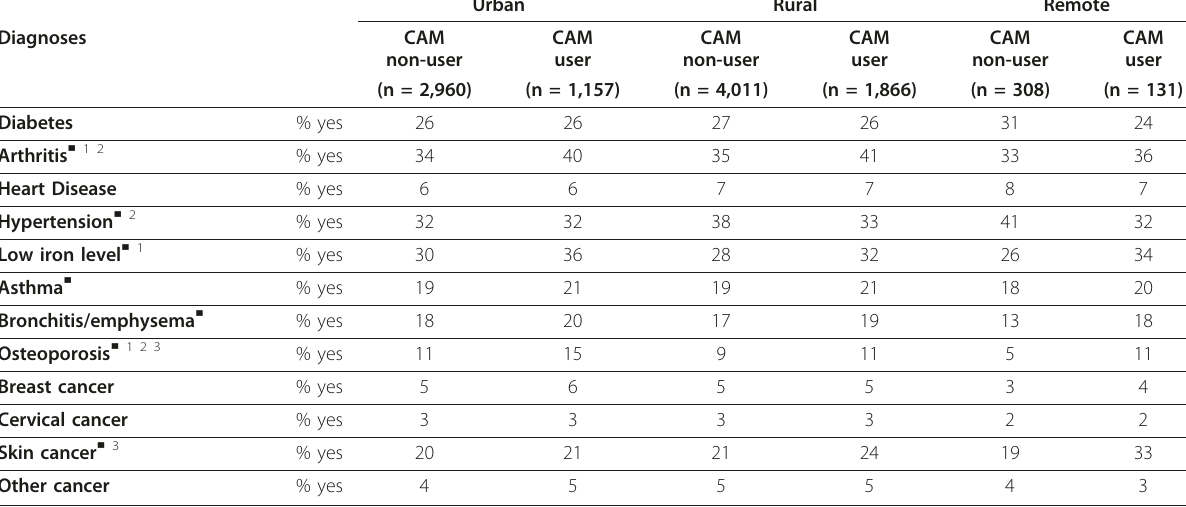
Table 4 Diagnoses by CAM user status (consulted with a CAM practitioner or not)